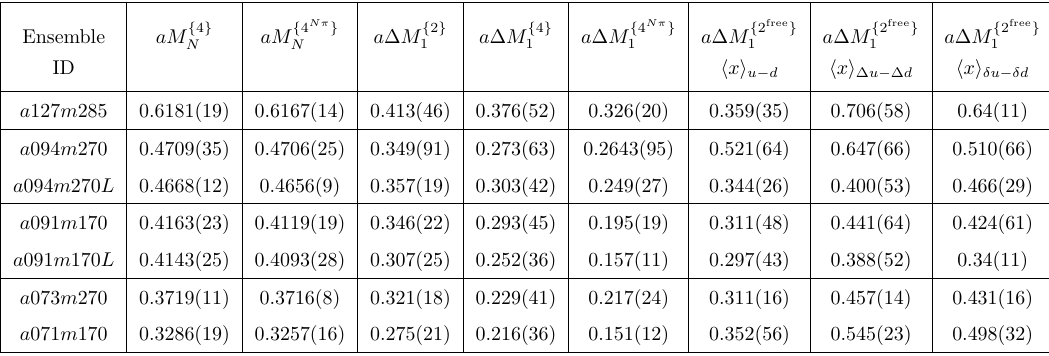
and aM { 4 Nπ } obtained from the two four-state fits N N